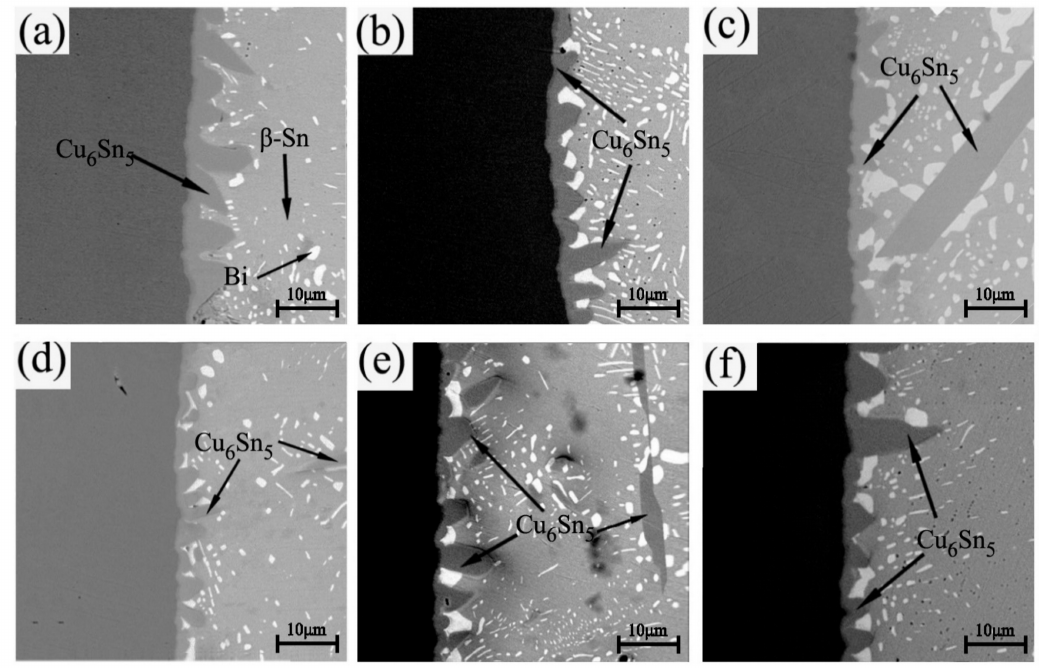
Figure 6. The interfacial microstructures at the Sn-20Bi-xGNS / Cu interface, ( a ) x = 0, ( b ) x = 0.02, ( c ) x = 0.04, ( d ) = 0.06, ( e ) = 0.08, ( f ) =